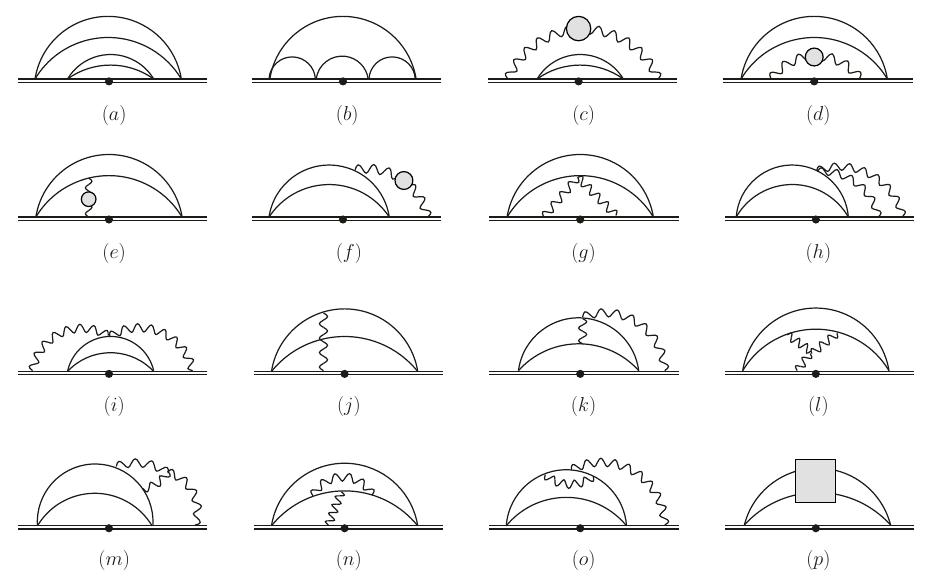
Figure 3. List of planar diagrams contributing to the four-loop (cid:18) -Bremsstrahlung function. Gray bullets stand for one-loop corrections to the gauge propagator. The gray box collects the two-loop corrections to the bi-scalar two-point function. Here solid lines stand for scalars and dashed lines for